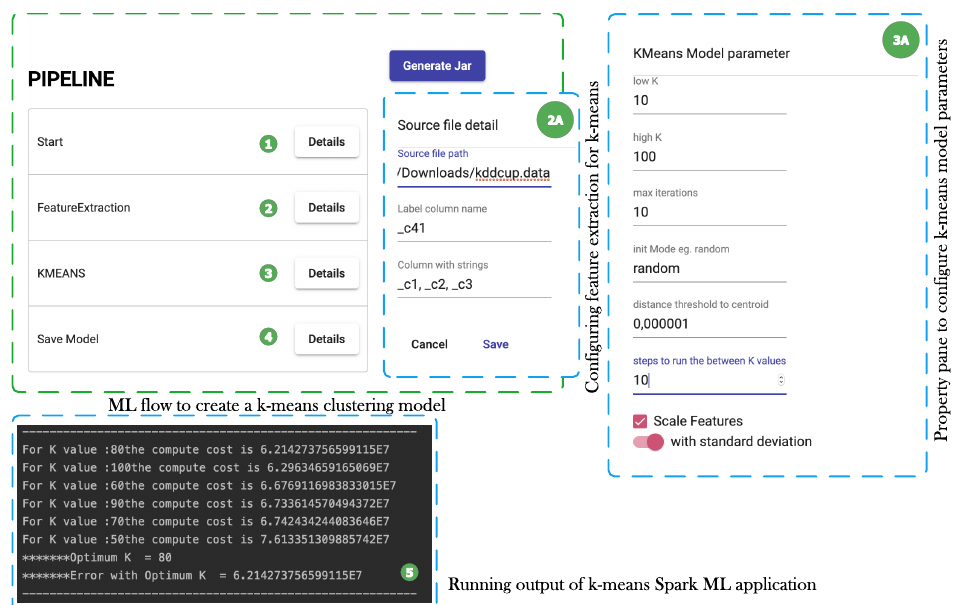
Figure 8. Graphical flow to create a k-means clustering model for anomaly detection.